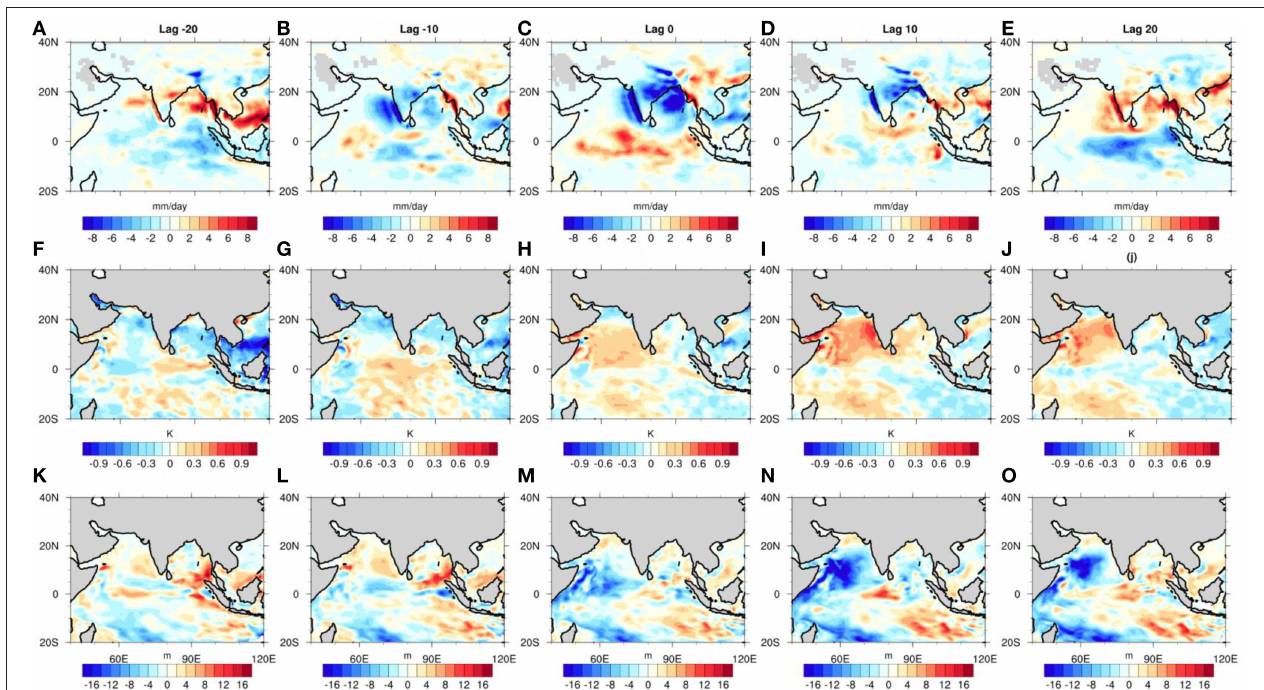
FIGURE 5 | Space-time evolution of composite rainfall anomalies during extended break episodes from CFSv2 simulations. Composite map is shown with lags from − 20 to + 20 days, where lag “0” represents the peak break phase over the NCEN. The top panels (A–E) show the evolution of rainfall anomalies (mm), the middle panels (F–J) represent the SST ( ◦ K) evolution, and the bottom panels (K–O) show MLT (m) anomalies.